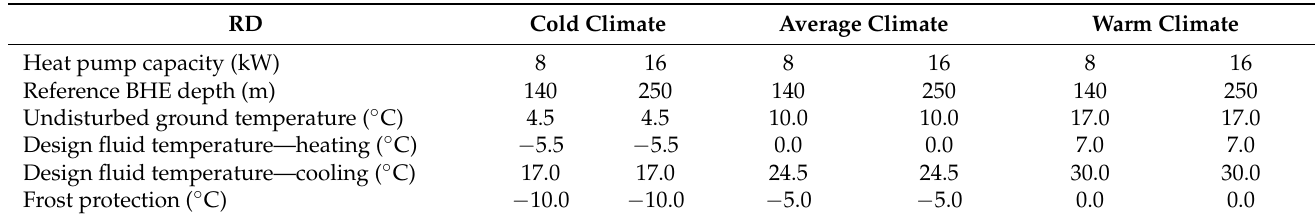
Table 4. Reference design for the two DSHP thermal capacities in three different climates